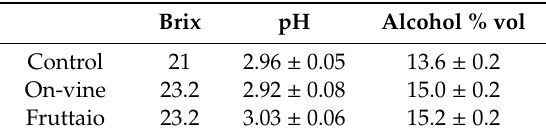
Table 5. Composition of Corvina wines made from not withered grapes, withered on-vine and withered in